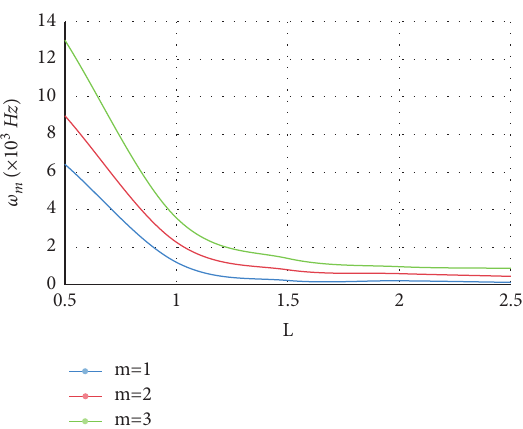
Figure 3: Relation between frequency and length of three-layered shells 0 0 /90 0 /0 0 ( GE / KE / GE ) ; n �